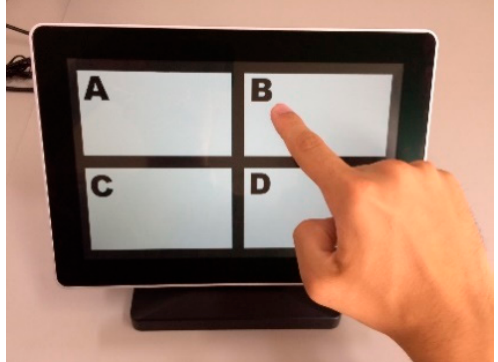
Figure 2. Example of user interaction with the TT device.